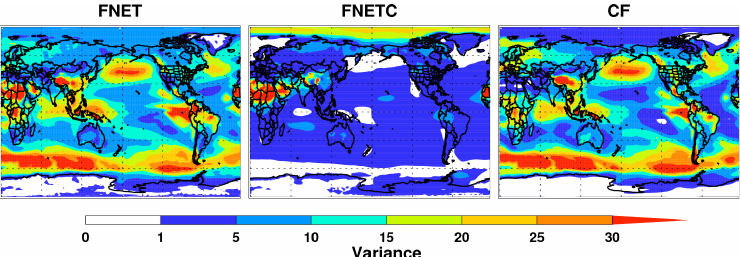
Figure 6 Global spatial distribution of variance of FNET, FNETC, and CF (unit in 1052 Fig. 6. Global spatial distribution of variance of FNET, FNETC, and CF (unit in W 2 m − 4 ) in response to the perturbations of 16 parameters from the 256 CAM5 W 2 /m 4 ) in response to the perturbations of 16 parameters from the 256 CAM5 1053